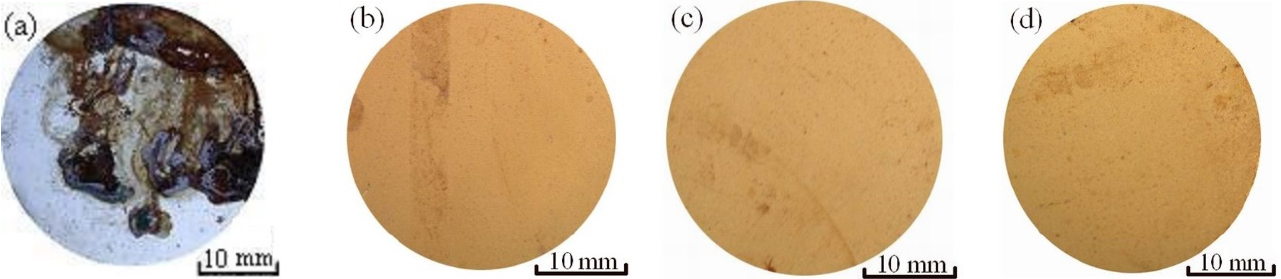
Figure 9. Corroded surface morphology of different samples. ( a ) AISI420, ( b ) Coating #1, ( c ) Coating #2, ( d ) Coating #3 after 720 h salt fog spray tests.